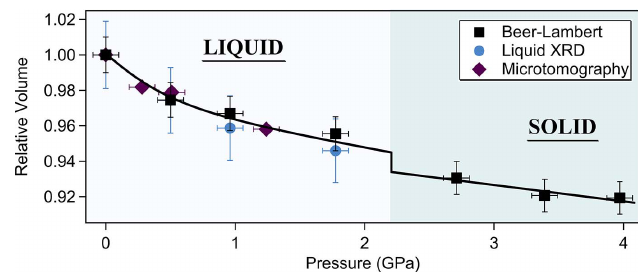
Figure 8 Summary of density measurements expressed in relative volume combining three techniques: absorption method (black square markers) obtained by mean values of results at 38 keVand 54 keV (the value of V 0 was taken from the density measurement at ambient conditions and 54 keVand was kept the same for the two energies); liquid XRD using the Eggert formalism (blue circle markers); and microtomography measure- ments (purple diamond marker). The black line is a guide to the eyes, median to the experimental